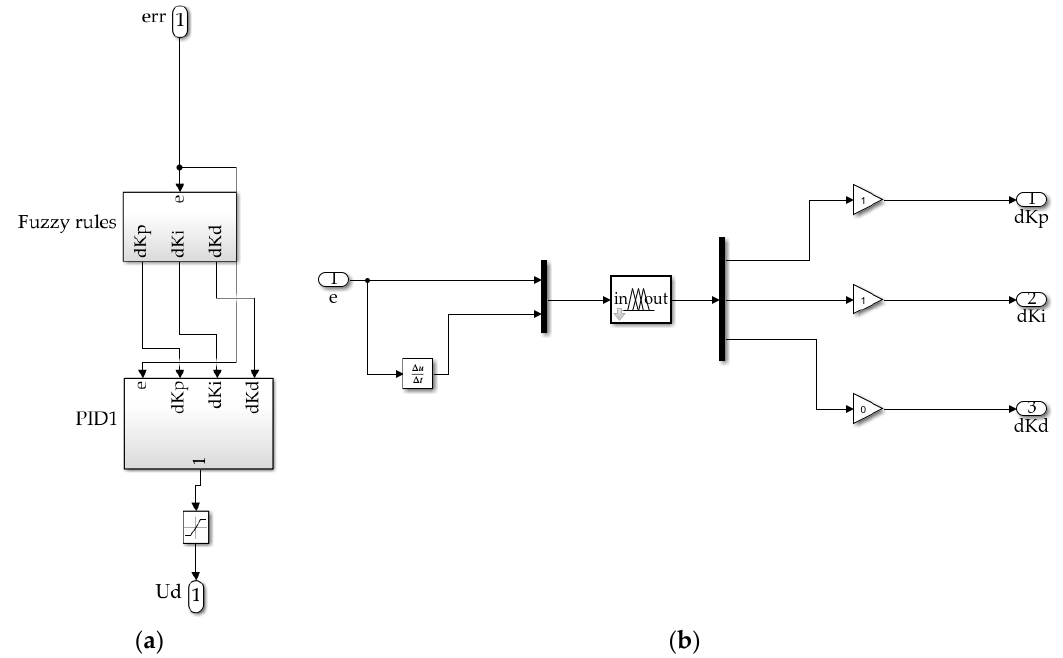
Figure 15. The coordinate transformation module ( a ) CLARK Transformation Module ( b ) PARK conversion module. The fuzzy PID controller is shown in Figure 16.